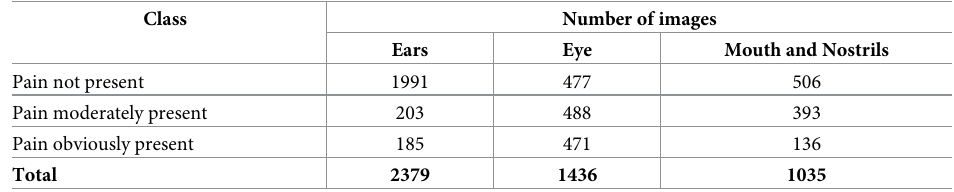
Table 1. Composition of final image